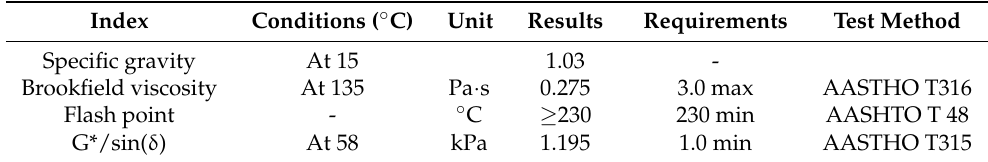
Table 1. Properties of the